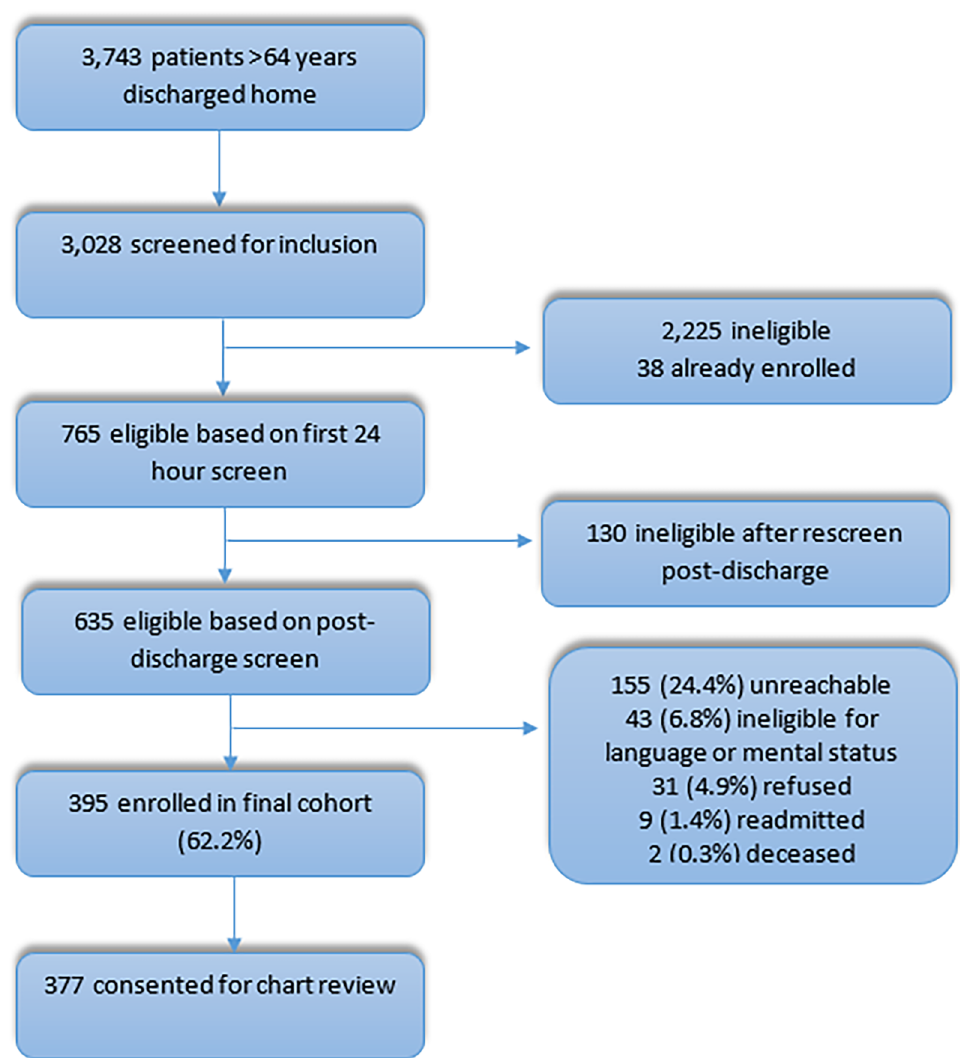
Fig 1. Flow diagram of enrolled